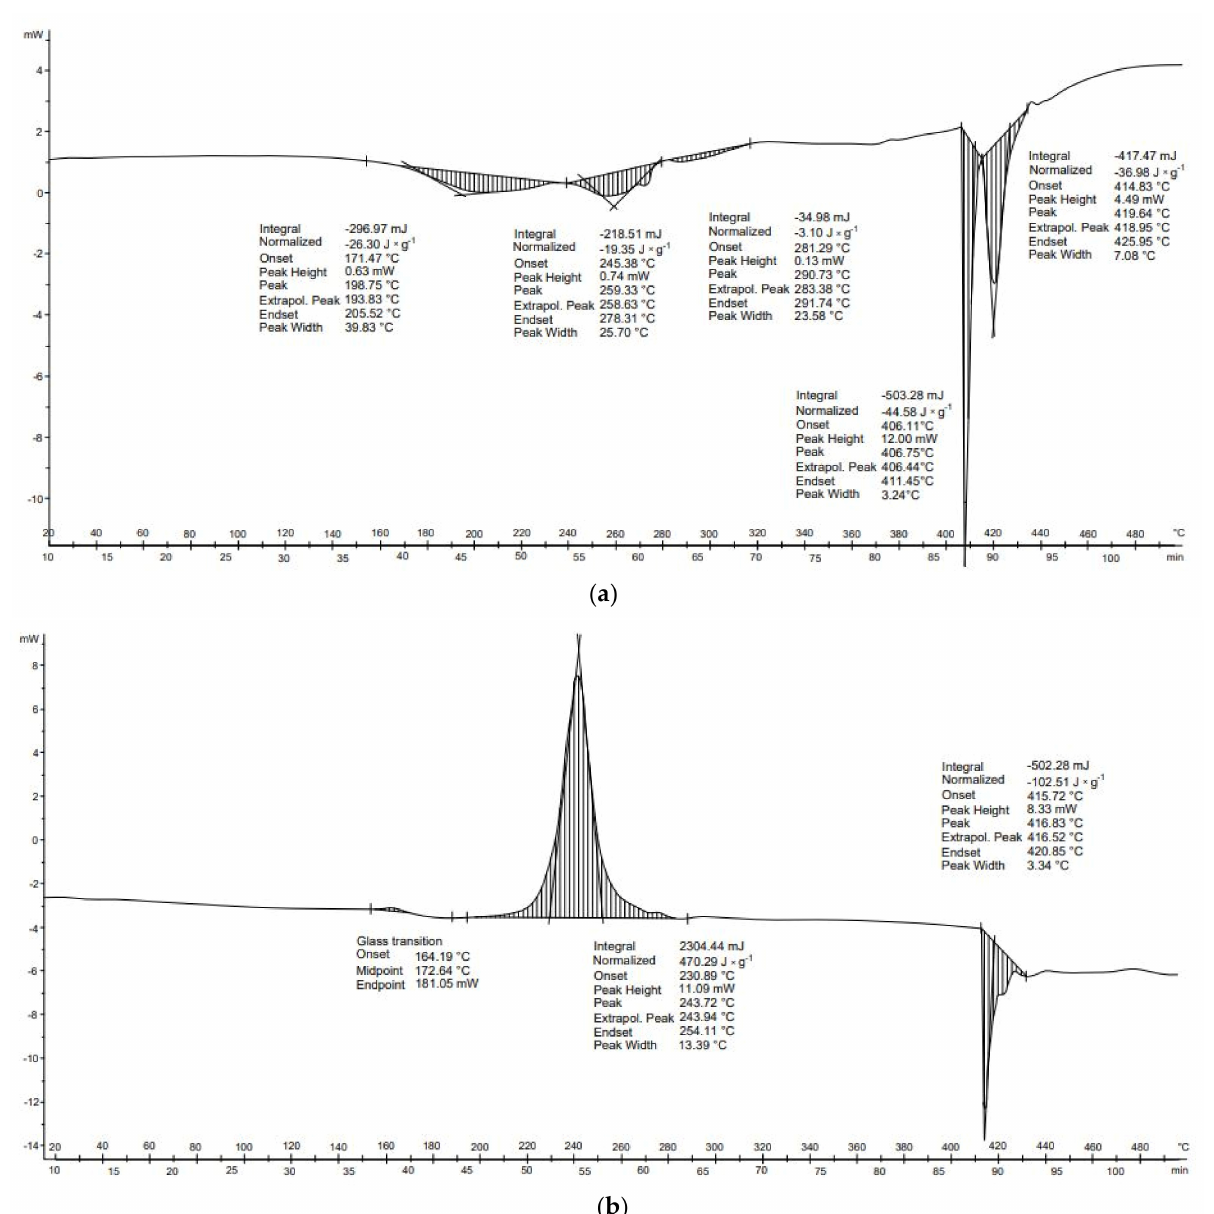
Figure 12. Characteristics of the DSC of biodegradable waste: ( a ) chicken meat; ( b ) potato peel. Potato peelings (Figure 12b) are characterized by three transformations: vitrifica- tion (164–181 ◦ C), exothermal transformation (234–254 ◦ C), and endothermal transforma- tion (416–421 ◦ C). The second, exothermal, transformation occurred at temperatures